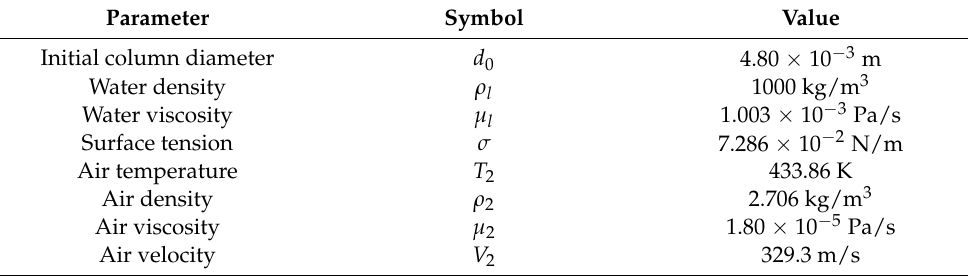
Table 2. Water column and post-shock air flow parameters.